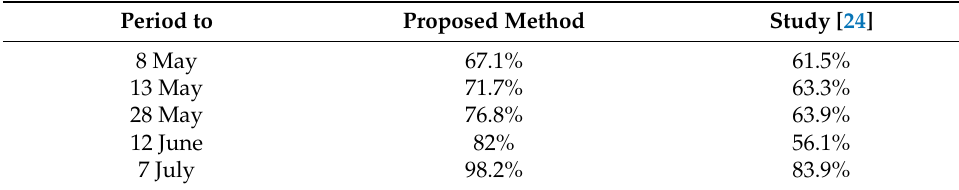
Table 14. Comparison of F1 identification accuracy of corn in 2020.